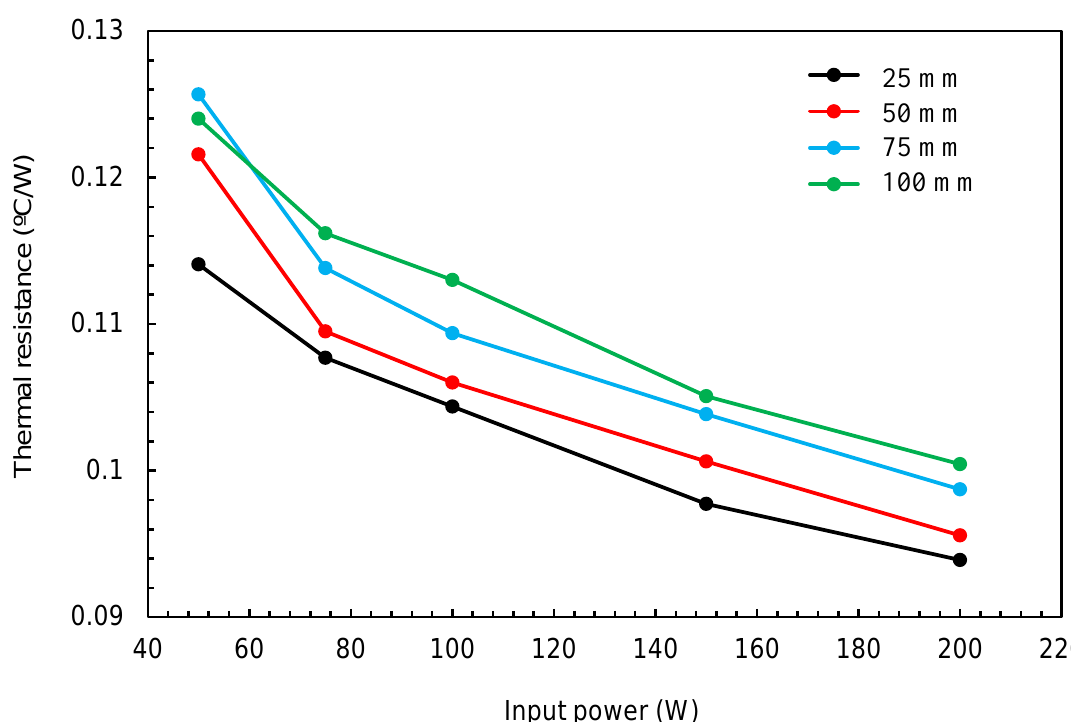
Figure 16. The effect of the downcomer level on thermal resistance. (riser height = 550 mm, downcomer exit = 25 mm, FR = 50%, inclination angle = 90°).